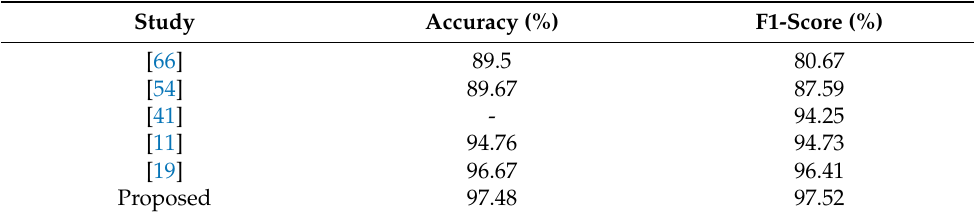
Table 4. Comparison of the results obtained with the KU-HAR dataset in previous